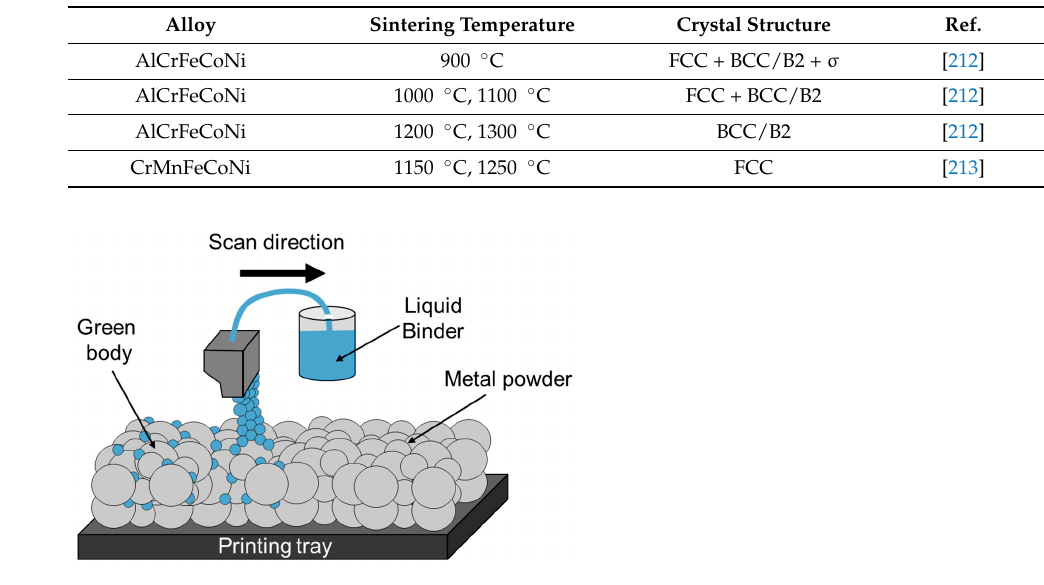
Figure 15. Schematic illustration of BJ process.